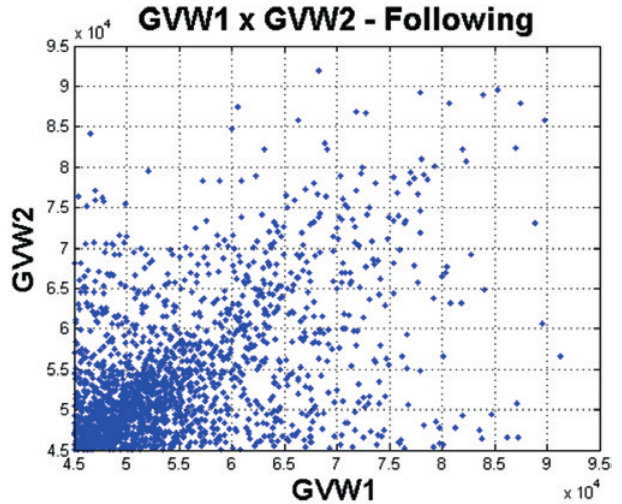
Relation of GVW 1 and GVW 2 in kg for following event – only heavy trucks